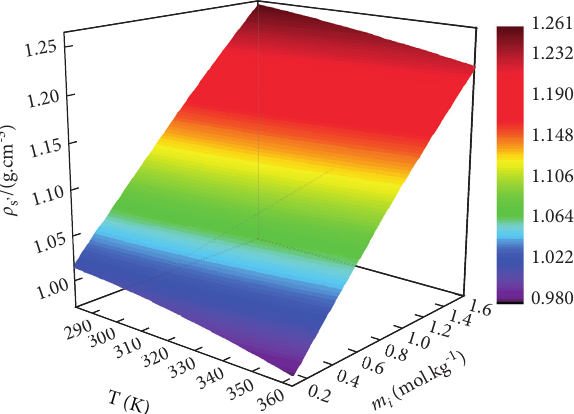
Figure 1: 3D diagram of the density of YCl 3 aqueous solution against temperature and molality at